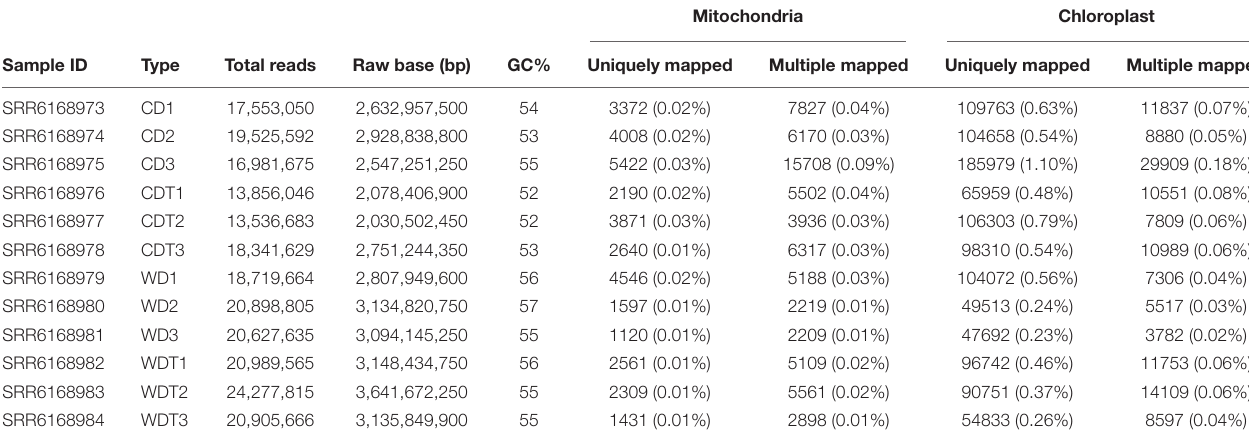
TABLE 1 | Summary of mapping rate to mitochondria and chloroplast genomes.